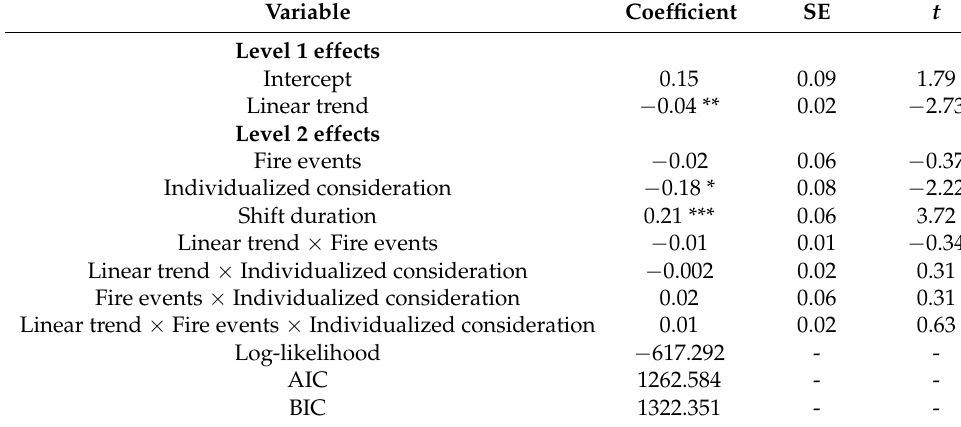
Table A9. Fire Events and Individualized Consideration Predicting Change in Emotional Exhaustion.